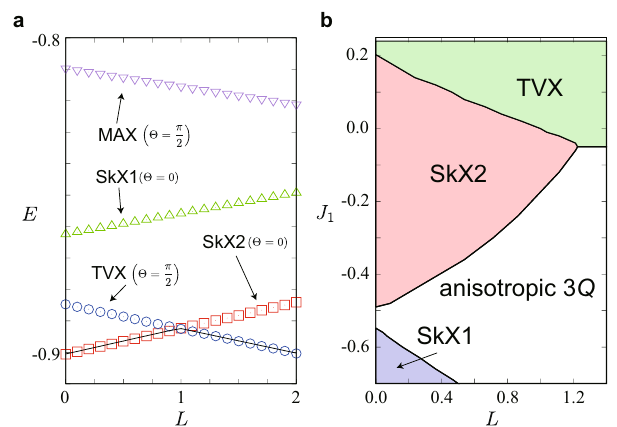
Fig. 4 Ground states of the effective spin model. a L dependence of the variational energy per site, E , at J = 1 and K = 0.4. The solid line shows the result by the simulated annealing down to temperature T = 10 − 4 for N = 96 2 . b Phase diagram on the L − J 1 plane obtained by the simulated